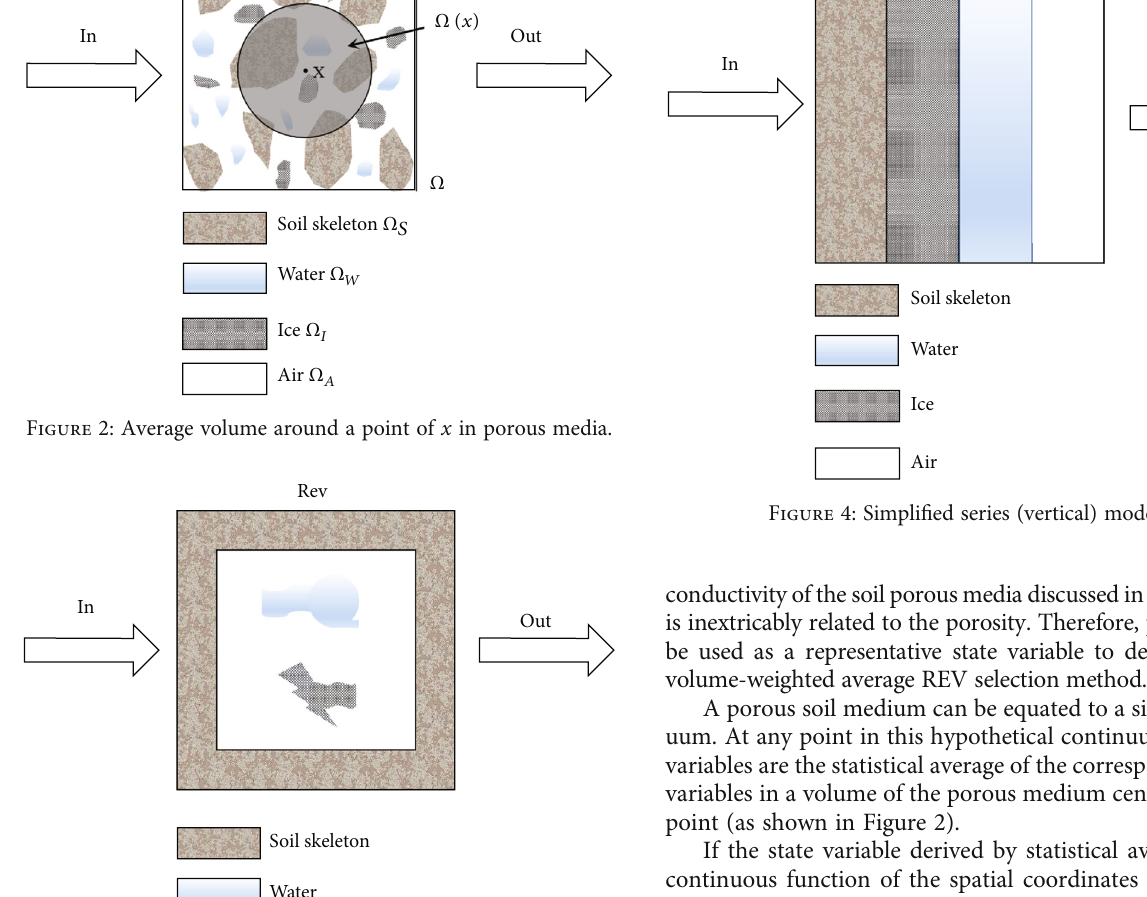
Figure 3: Simpli fi ed volume-weighted average REV model.